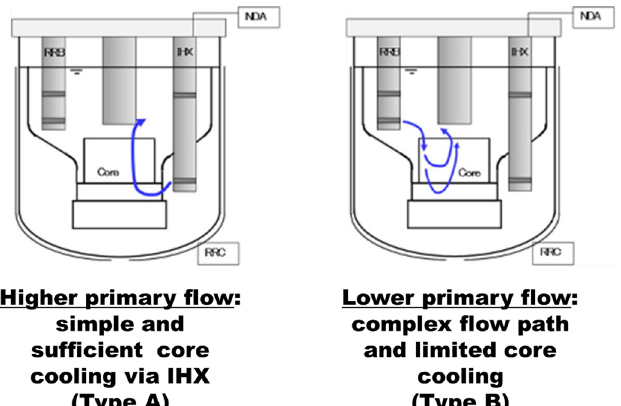
Fig. 8. DHR fl ow pattern in MV to be